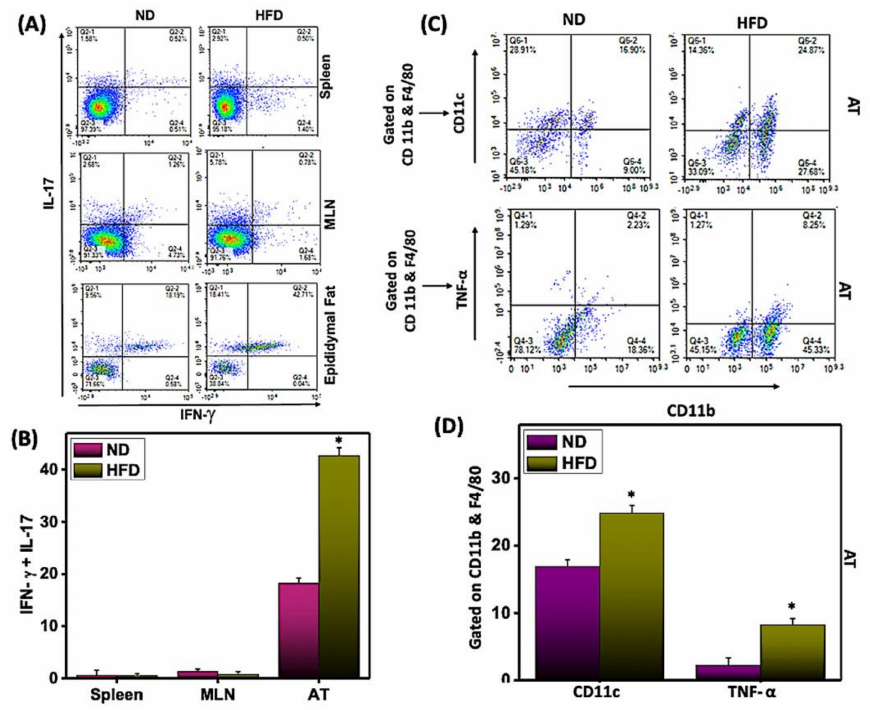
Figure 4. HFD induces IFN- γ + Th17 + cells in AT. AT-derived cells were isolated from the two groups of mice as described in Figure 2 and analyzed by flow cytometry with antibodies specific for Th17 and IFN- γ . Changes in the frequency ( A ) and percentage of Th17 + IFN- γ + cells ( B ) in the systemic and AT environments were expressed as the mean percentage of cells/mice ± SEM. Further, changes in the frequency and percentage of M1 macrophage (CD11c and TNF- α gated on CD11b+F4/80) cells ( C , D ) in the AT were expressed as the mean percentage of cells/mice ± SEM. Histograms are shown from a representative experiment. The percentage change is shown by combining the mean of the three independent experiments involving six mice/groups that yielded similar results. Asterisks (*) indicate statistically significant differences ( p < 0.01) between ND and HFD